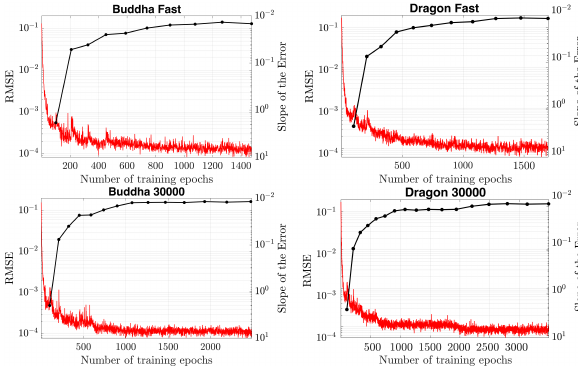
Figure 6. RMSE of the GNG network (red) and slope of the error (black, inverse y -axis) for four different runs: FM (top row) with Buddha ( k max = 10 ) on the left side and Dragon ( k max = 11 ) on the right side. The same constellation is provided in the bottom row, ( k max = 14 and 17 ) for DM with ρ user = 30 , 000